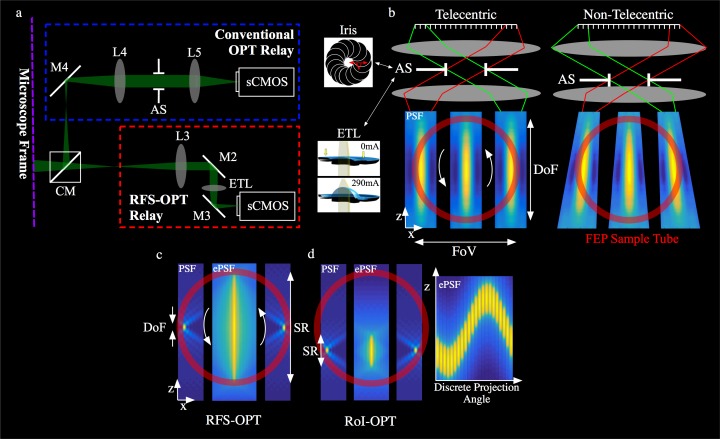
(a) External relay added to the camera port of the microscope for higher magnification standard OPT and remote focal scanning OPT (RFS). A continuation of the components within the microscope frame (Fig 1(C)), CM removable cube mirror. External RFS-OPT relay (red box): L3 achromatic doublet, M2/M3 mirror cubes, ETL electrically tunable lens. Conventional OPT relay (blue box): M4 mirror, L4/L5 achromatic doublets, AS variable iris acting as aperture stop. (b) The variable iris or ETL act as the aperture stop in the conventional or RFS OPT systems respectively. The size of the iris or scan range of the tunable lens determine the respective DoF, but axial displacement away from the conjugate pupil plane can lead to non-telecentric performance. The 3D axial PSF is no longer shift invariant, resulting in a depth dependant magnification. Note the point spread functions are scaled for illustrative purposes. (c,d) Simulation showing the static axial PSF (exterior panels) and effective axial PSF(central panels) for RFS-OPT and region of interest (RoI) OPT. (c) RFS-OPT with a scan range covering the full axial extent (d) RoI-OPT uses a smaller SR to increase the contrast to noise ratio over a desired region of interest. The RoI is tracked in depth, by adjusting the focal offset required to track the RoI during an acquisition (i.e as the sample rotates to each projections angle).